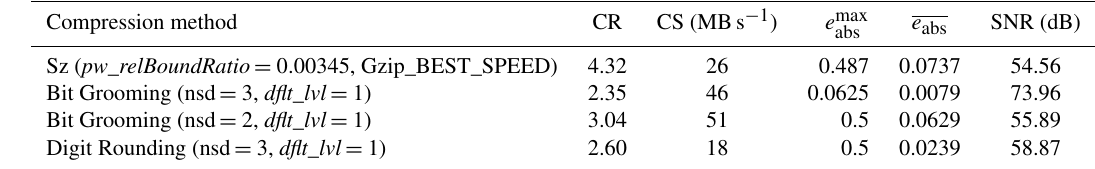
Table 7. Compression results of Sz, Bit Grooming, and Digit Rounding in relative error-bounded compression mode on dataset s3D . Compression